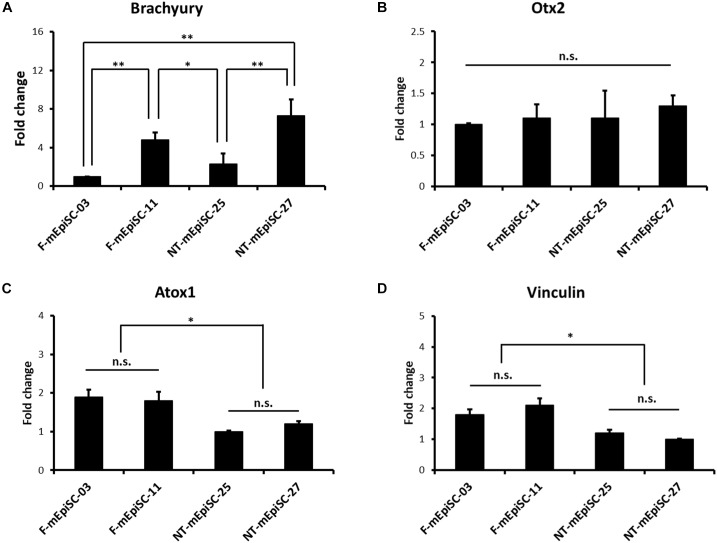
qPCR analysis of the genes expression relative to the neurogenesis efficiency in undifferentiated F-mEpiSCs and NT-mEpiSCs. (A,B) The expression of Brachyury and Otx2 in undifferentiated F-EpiSCs and NT-EpiSCs was not related with their differentiation potential. (C,D) The expression of Atox1 and Vinculin was significantly lower in undifferentiated NT-EpiSCs, which indicated the NT technique perhaps the underlying reason of neurogenesis hysteresis. GAPDH was used as endogenous control. n.s., P > 0.05; ∗P < 0.05; ∗∗P < 0.01.